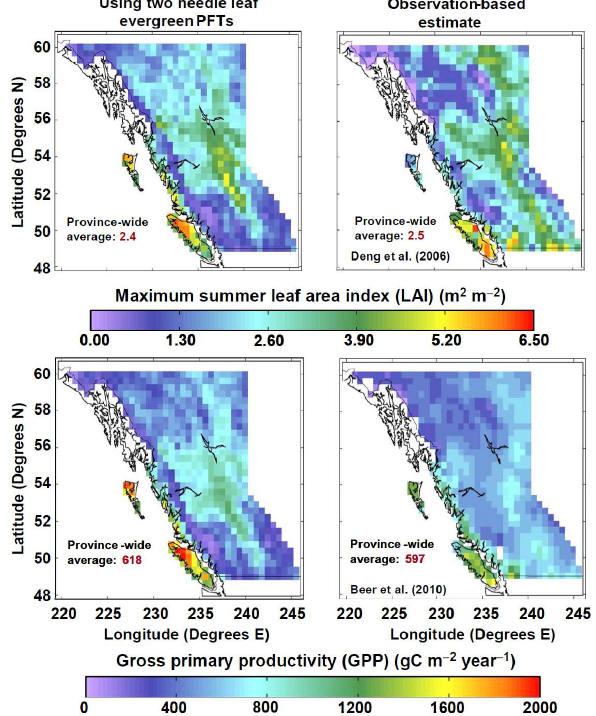
Fig. 3. Geographic distribution of simulated maximum leaf area index (LAI) and gross primary productivity (GPP) for BC com- pared to observation-based estimates. The left column shows results from the CLIM + CO 2 simulation that considers coastal and interior needleleaf evergreen PFTs separately. LAI observations are from Deng et al. (2006) averaged over the 2000–2005 period, and GPP observations are from the global product of Beer et al. (2010). The model results are averaged over the same respective periods as